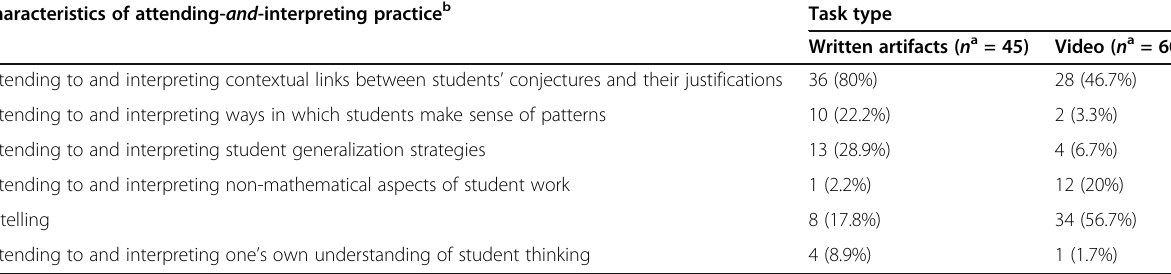
Table 2 Features of the attending-and-interpreting practice Characteristics of attending- and -interpreting practice b Task